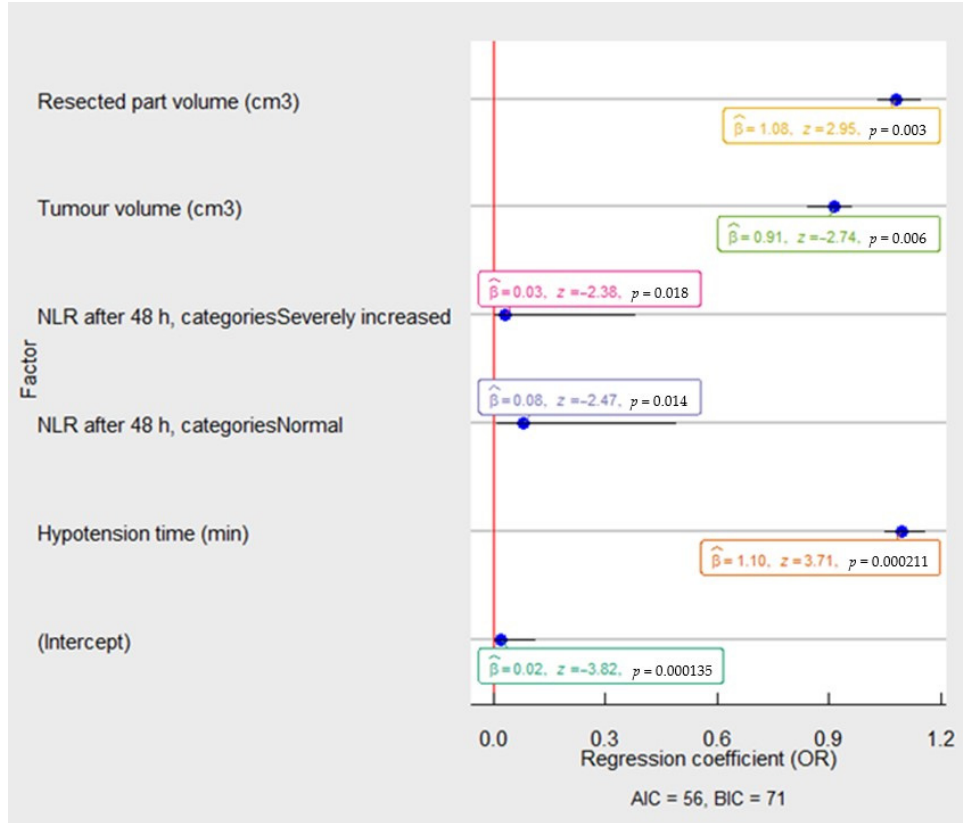
Figure 4. The multivariable analysis of risk factors associated with clinically significant postop- erative kidney dysfunction in the patients after partial nephrectomy. The OR and 95% CI were measured through logistic regression. Model characteristics: X 2 = 54.38, p = 0.00; Pseudo − R